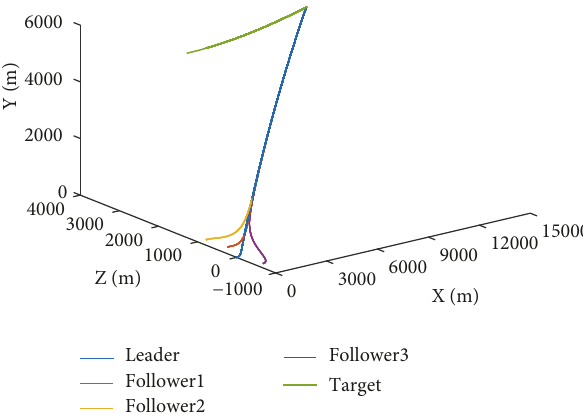
Figure 4: Motion trails of the interceptor “leader,” “follower,” and target in the local communication topology. X denotes the horizontal motion trail of the interceptor and target, Y denotes the longitudinal motion distance of the interceptor and target, and Z denotes the lateral motion trail of the interceptor and target.